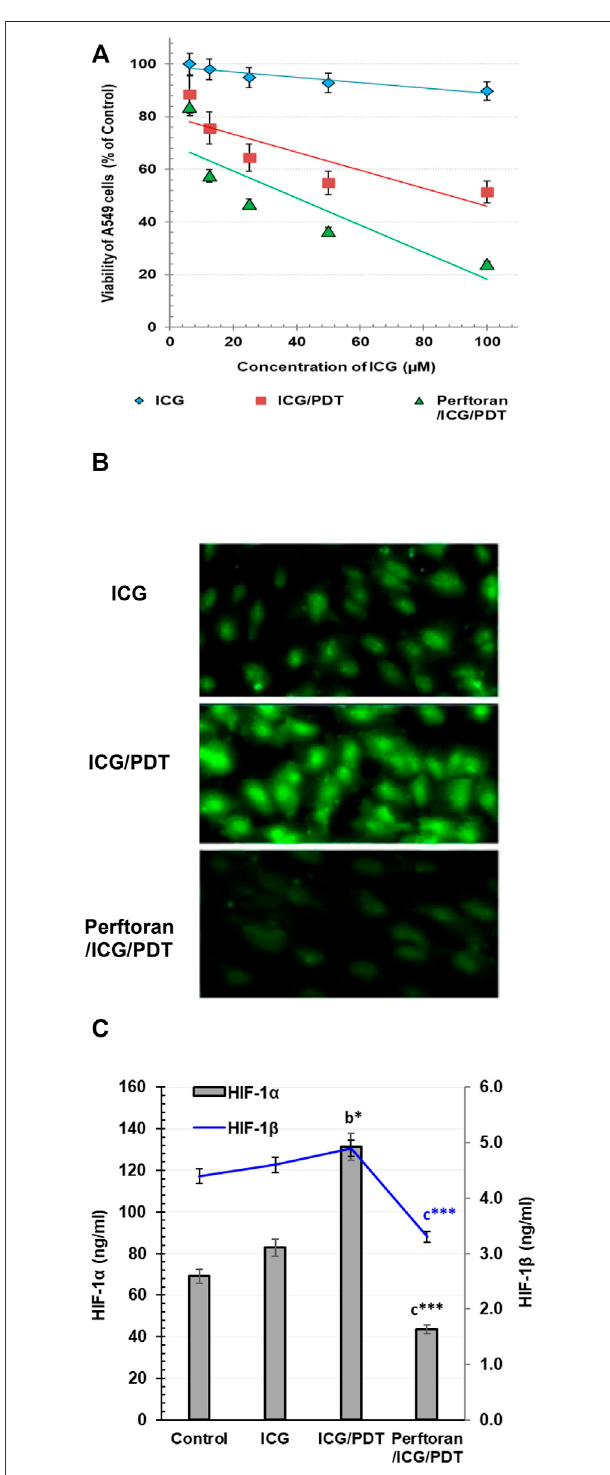
FIGURE 1 | (A) Cytotoxicity: The viability of A549 as estimated by MTT assay. The viability is presented as % of the control (mean ± SD; n = 8). (B) Alteration in total hypoxia level in A549 cells: Detection of the change in the total hypoxia was explored by pimonidazole, which interacts with thiol groups in proteins in hypoxic cells to form green fl uorescent adducts. Cells